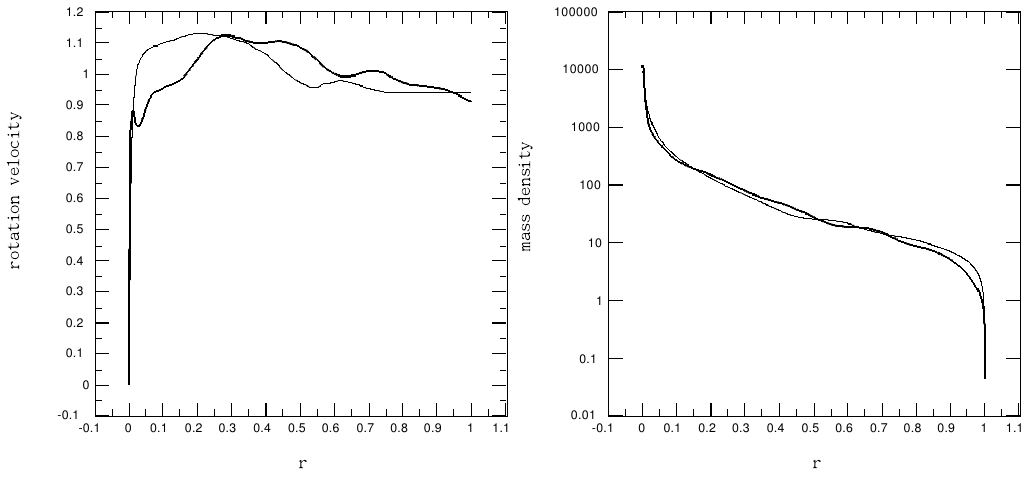
Figure 4. Profiles of NGC 224 and NGC 5055 rotation velocity V ( r ) and mass density ρ ( r ) , with the thick line for that of NGC 224 and the thin line for NGC 5055 . The computed values of the galactic rotation number, A , are 1 . 6450 and 1 . 6888 for NGC 224 and NGC 5055 , respectively.